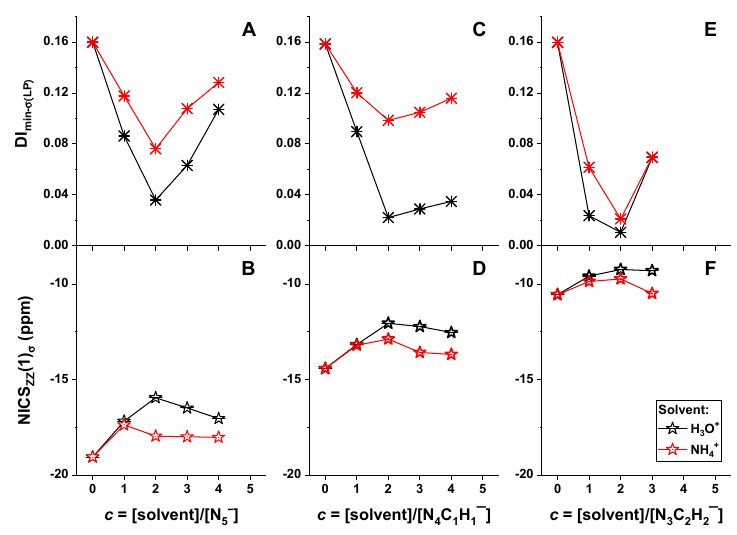
Figure 4. DI min- σ (LP) and NICS zz (1) σ of ( A , B ) N 5 ¯ , ( C , D ) N 4 C 1 H 1 ¯ , and ( E , F ) N 3 C 2 H 2 ¯ with increasing concentration of H 3 O + and NH 4+ .